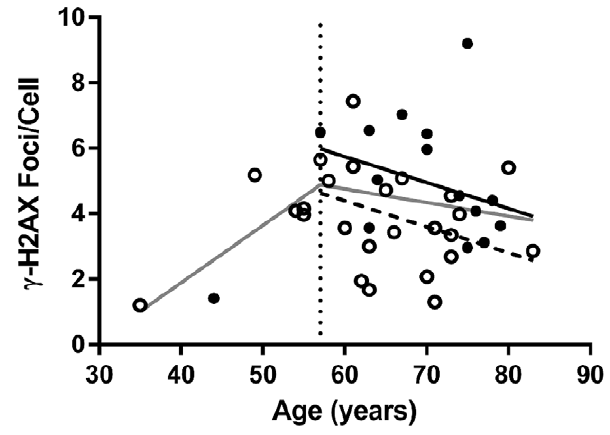
Figure 4. Scatterplot of c -H2AX foci/cell in mononuclear cells by age for patients with and without hypertension. Solid circles indicate patients with hypertension; hollow circles indicate those without hypertension. Solid line indicates best fit line for hypertension patients age 57 and over. Dashed line indicates best fit line for non- hypertensive patients age 57 and over. Light line indicates regression curve for all patients. Fig. 3C ) following adjustment for age and sex. The relationship between hypertension and c -H2AX foci might begin earlier than 57 years of age as we found that analysis of patients 44 years of age and older also revealed a statistically significant ( p = 0.020) 33%